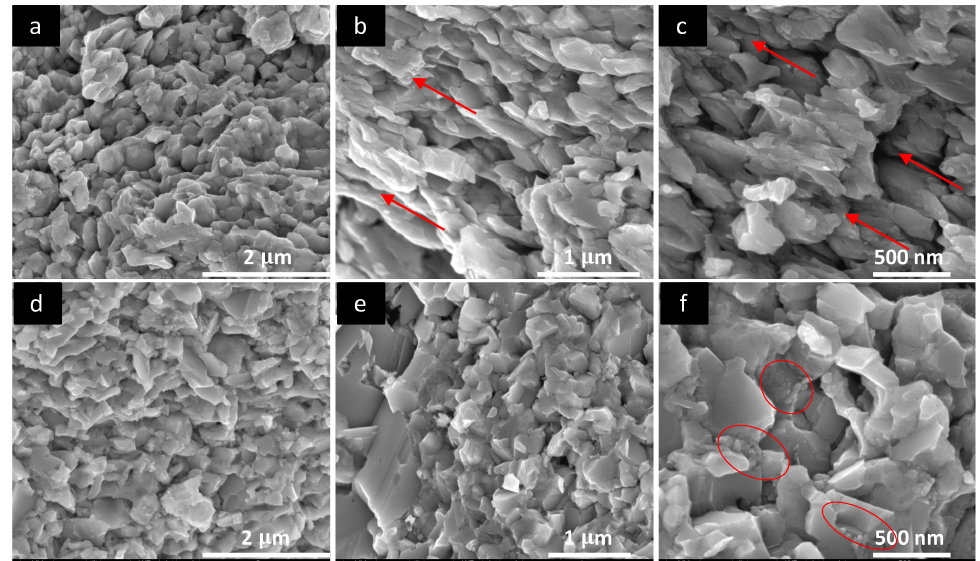
Figure 5. SEM micrographs of SPS sintered Cu 1.8 Se ( a – c ) and Cu 2 Se ( d – f ) samples at different magnifications. A higher order of similarly sized and partly oriented grains were observed in ( b ) and (c) for Cu 1.8 Se (designated by arrows) in comparison with Cu 2 Se (circled regions) in ( d ).